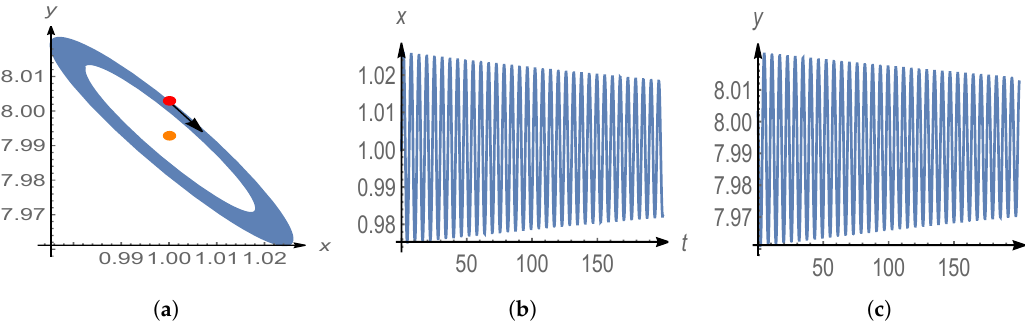
Figure 7. Model 1 with a stable outer and an unstable inner limit cycle. The trajectory is going inward, approaching the singular point as t tends to + ∞ and the small limit cycle as t tends to − ∞ . The distance of the initial point from the singular point is d =